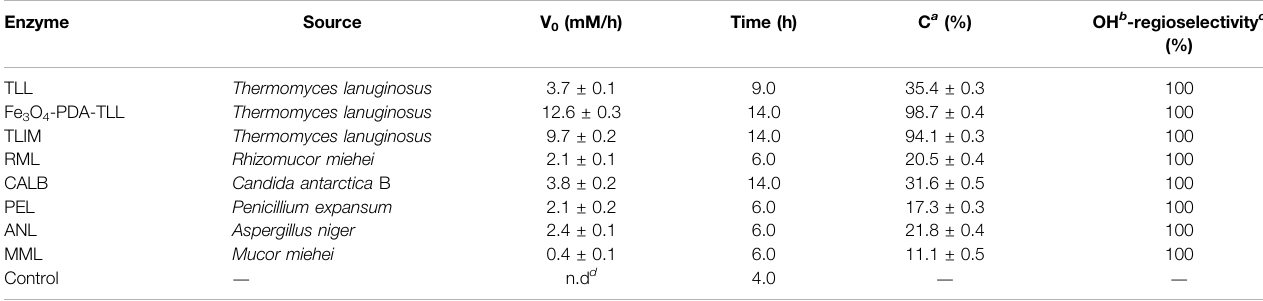
TABLE 1 | Regioselective decanoylation of polydatin catalyzed by various lipases.: Enzyme